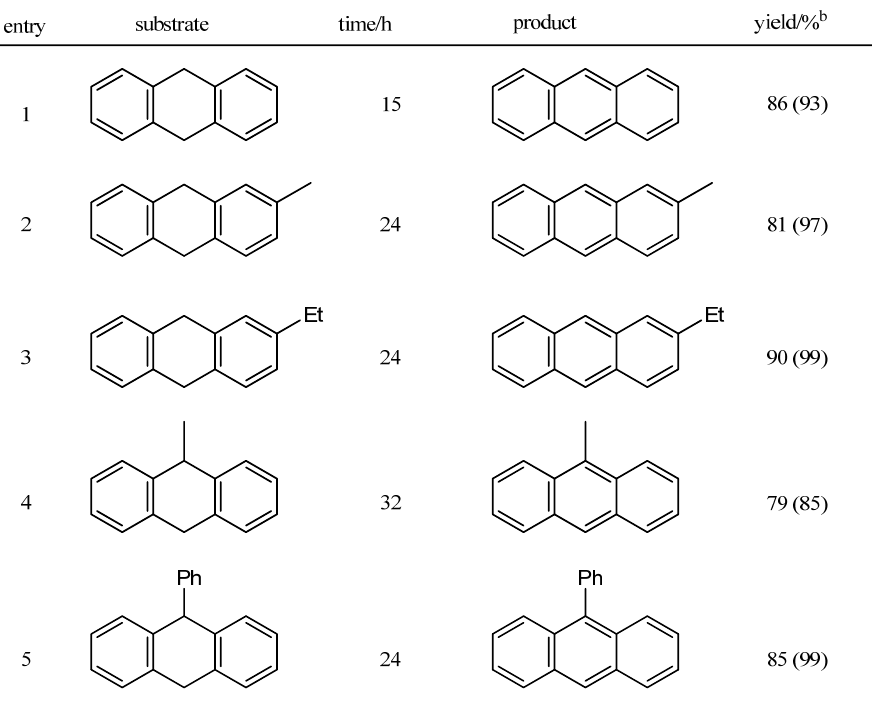
Table 10. Aromatization of substituted